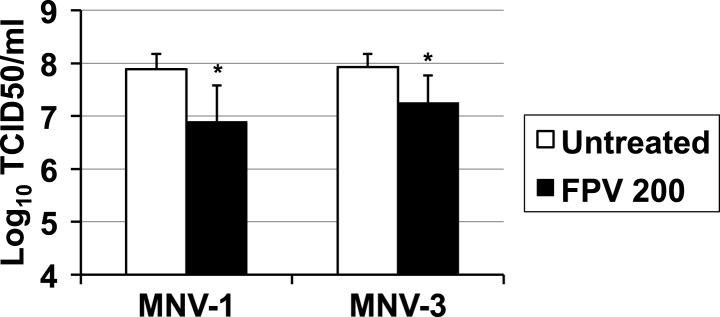
Reduced virus yields in favipiravir-mutagenised populations.RAW264.7 cells were infected with MNV-1 or MNV-3 recovered after 5 passages in the absence (untreated) or presence of favipiravir (200 μM) Infections were performed at an MOI of 0.01. After adsorption (1 hr at 37°C), virus inoculum was removed and complete media added to infected cultures. Infected cells were then incubated as mentioned in ‘Materials and methods’ for a total of 17 hr before freezing.